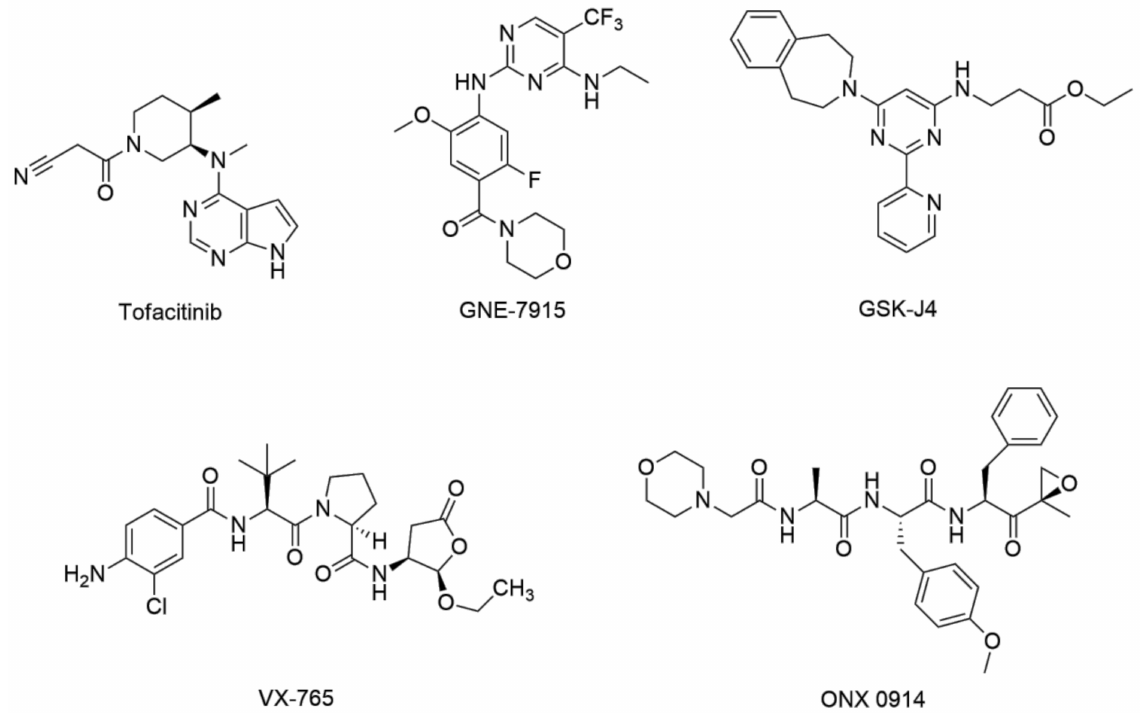
Figure 1. Chemical structures of small molecule inflammatory cytokine